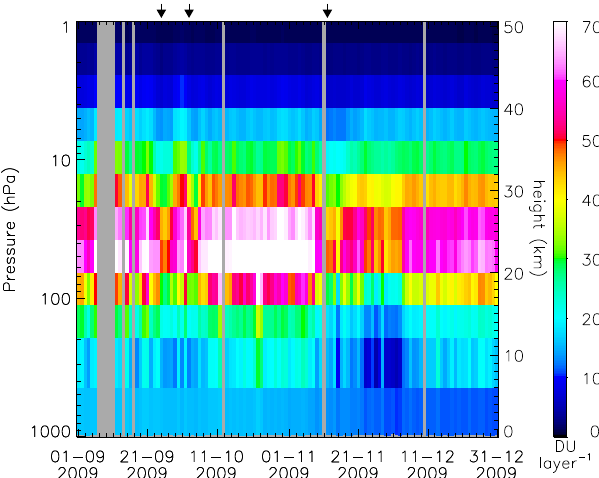
Fig. 16a. The mean of the absolute differences for collocations that occurred inside of, or close to, the vortex. The retrieval is plotted in blue and the a priori in red. The solid line is the mean, and the dashed lines are the ± 1 standard deviations. The first number in the column on the left side is the number of collocations between GOME-2 and the lidar, and the second number is the mean number of lidar layers averaged for that layer during interpolation.